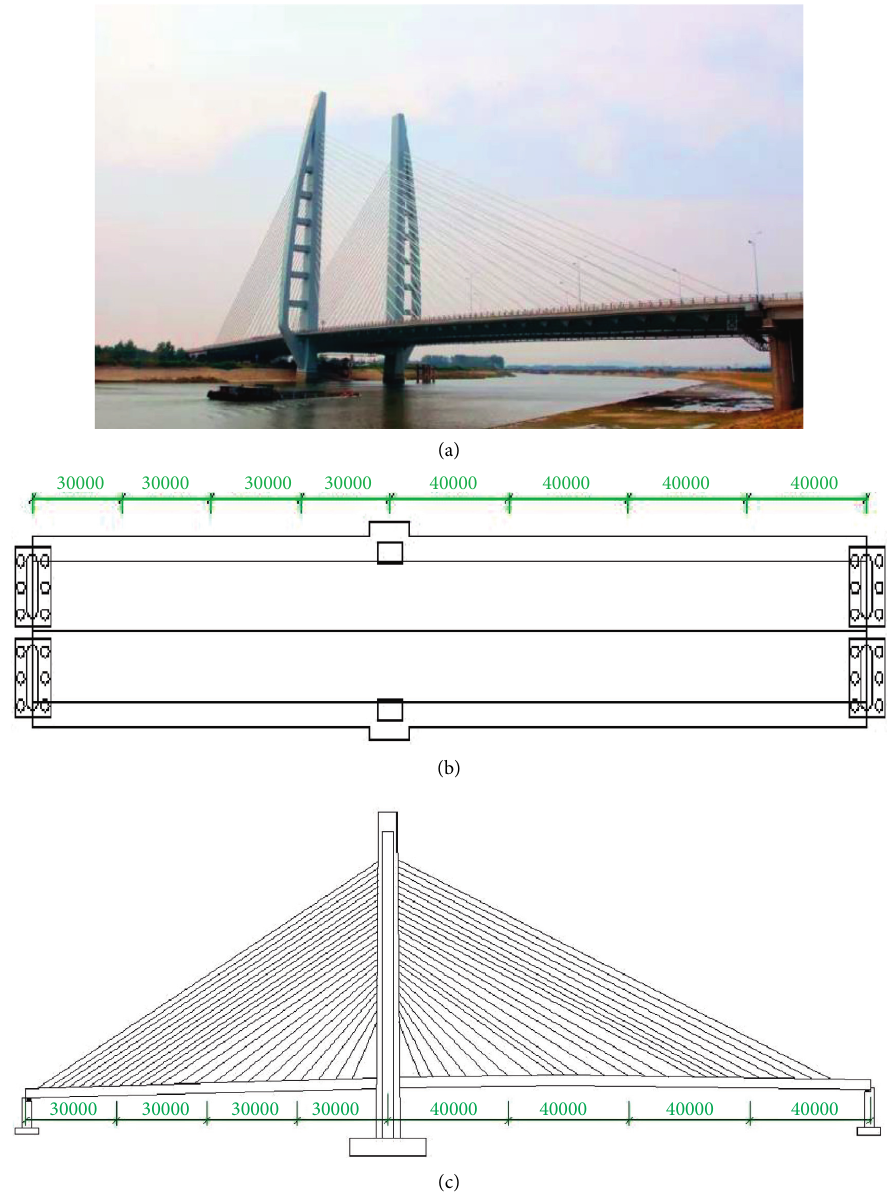
Figure 1: The Nanfeihe Bridge tested in this paper. (a) The actual view of Nanfeihe Bridge. (b) The plain graph of Nanfeihe Bridge. (c) The elevation of Nanfeihe